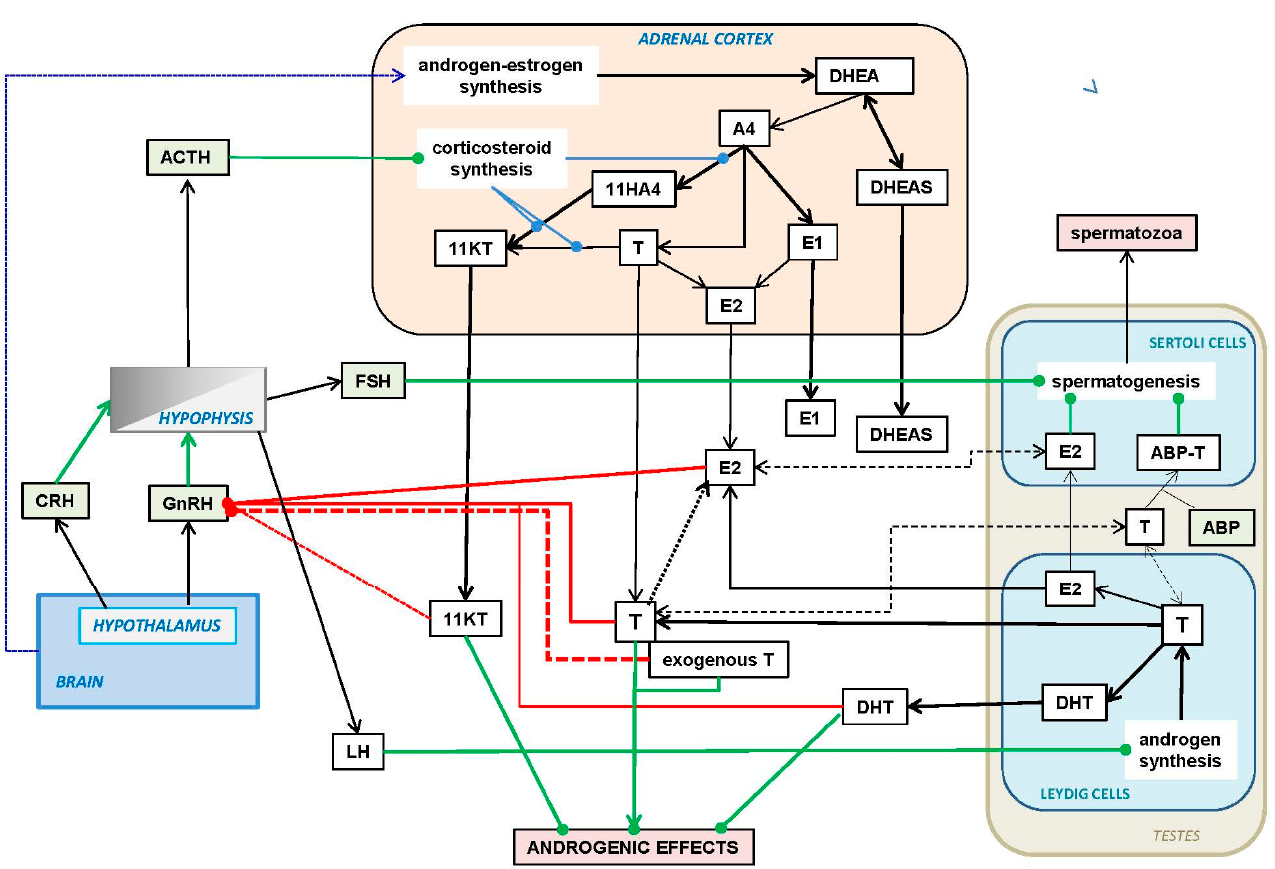
Figure 5. Regulation of the androgen (and estrogen) synthesis by the adrenal cortex and testes. Abbreviations: GnRH: gonadotropin-releasing hormone; CRH: corticotropin-releasing hormone; ACTH: corticotropin; (gonadotropins) FSH: follicle-stimulating hormone; LH: luteotropic hormone; E1: estrone; E2: 3,17 β -estradiol; ABP: androgen-binding protein. The other abbreviations have been described in Figure 2. The solid black arrows show paths or relationships. The dotted black line depicts the brain modulation of steroid hormone synthesis by the brain through other additional means (i.e., nervous signals and non-steroidal hormones). The dashed black lines indicate the possibility of direct interchange of pools between tissue and blood. The green lines show stimulatory/activating effects, and the red lines inhibitory/deactivating effects. The effects of exogenous T (i.e., administered as a drug) on GnRH functions overall have been presented as a red dashed line to somehow differentiate it from the tissue-released T.